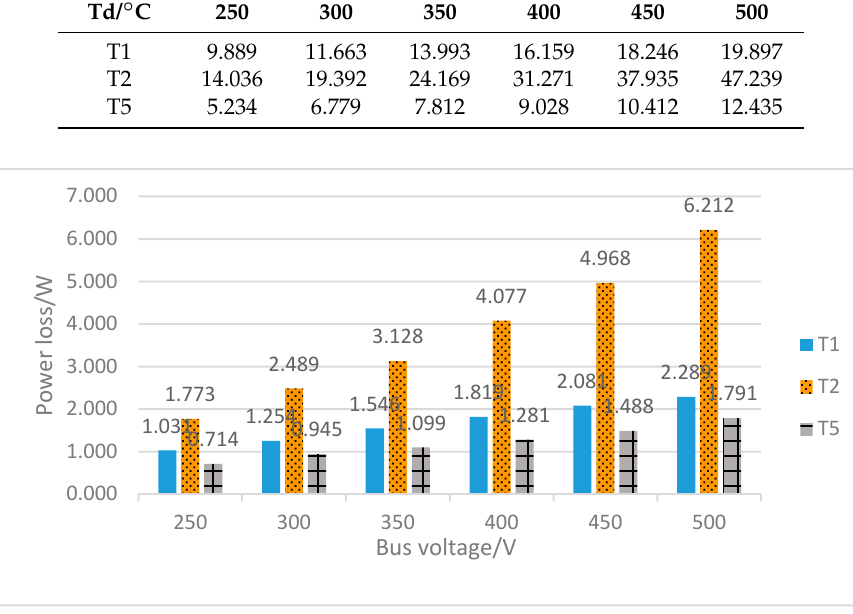
Figure 13. Loss distribution of T1, T2, and T3 under different bus voltages.